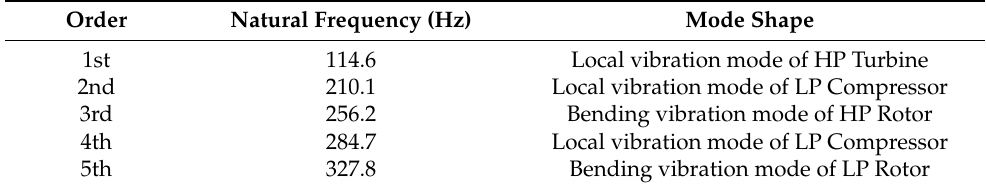
Table 2. The first five